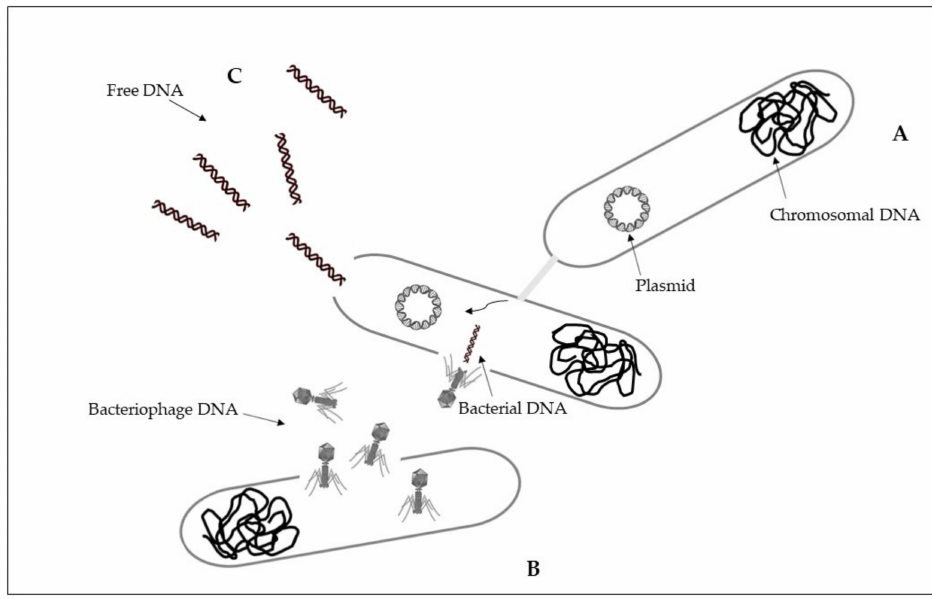
Figure 1. Horizontal gene transfer: ( A ), conjugation; ( B ), transduction; ( C ), transformation. See text for